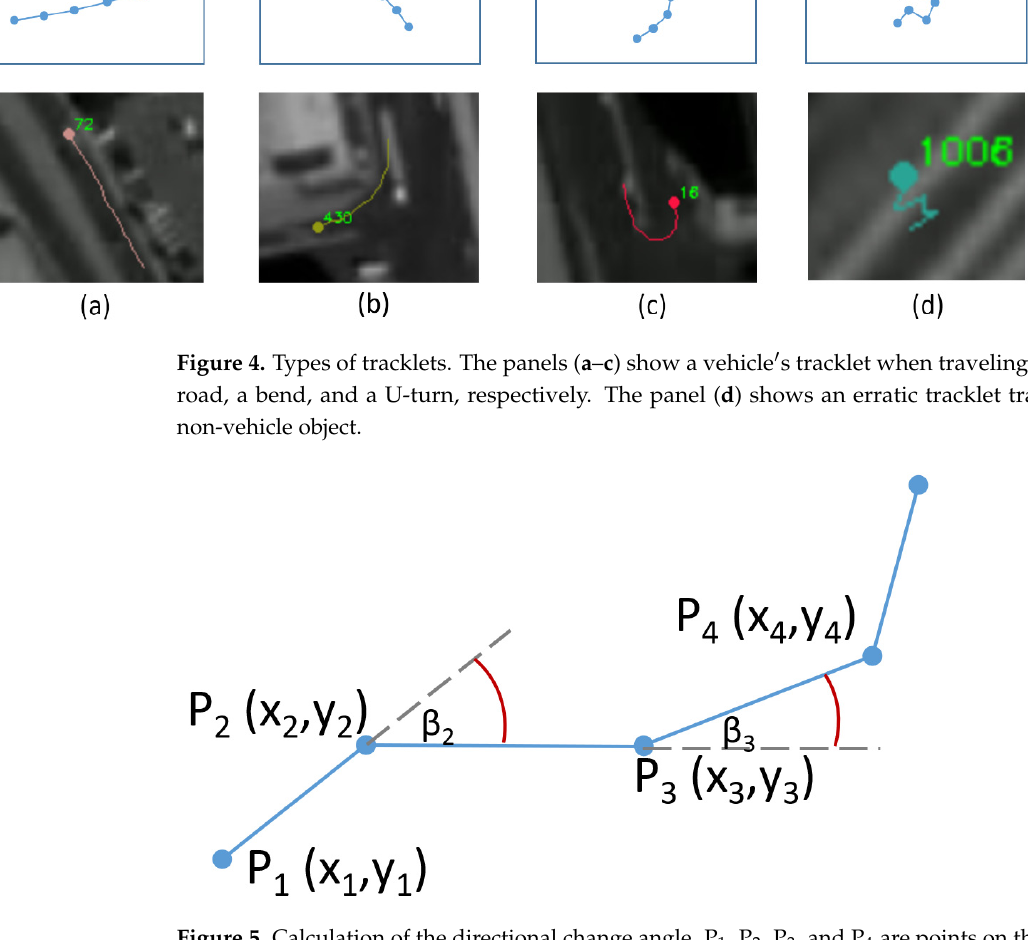
Figure 5. Calculation of the directional change angle. P 1 , P 2 , P 3 , and P 4 are points on the tracklet. β 2 and β 3 are two directional change angles formed by P 1 , P 2 , P 3 , and P 4 .